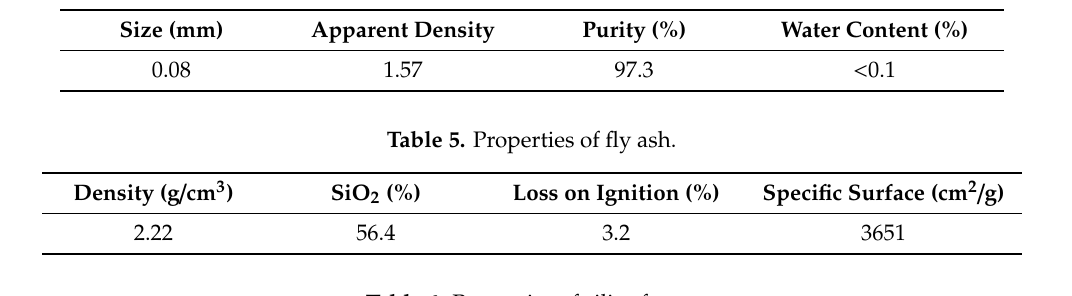
Table 6. Properties of silica fume.